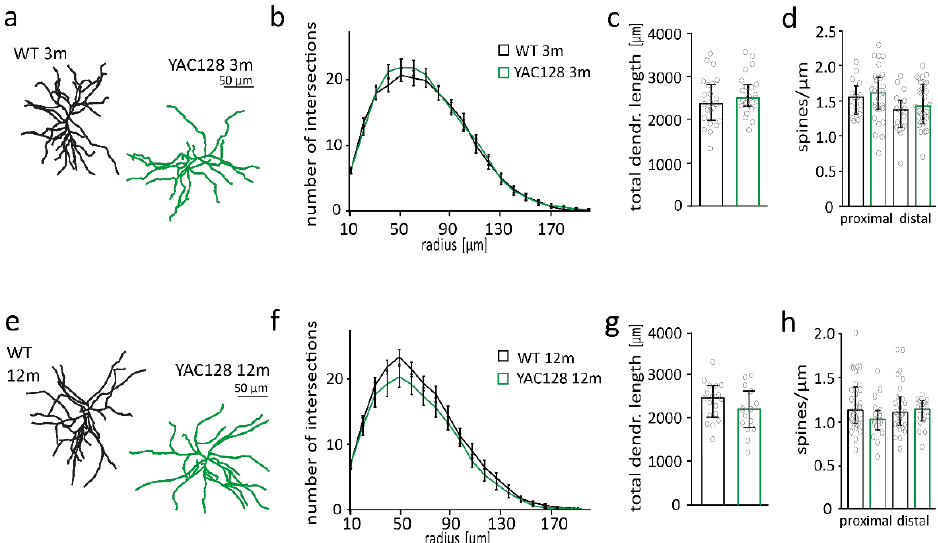
Figure 1. Neuron morphology is unaltered in 3- and 12-month-old YAC128/BL6 mice. ( a ) Examples of reconstructed medium spiny neurons (MSNs) from 3-month-old WT and YAC128/BL6 mice. ( b ) Sholl analysis with number of dendrite intersections and ( c ) bar graph of total dendritic length of MSNs from WT ( n = 23) and YAC128/BL6 ( n = 23) mice. ( d ) Bar graph of spine number per micrometer of proximal and distal dendrites of MSNs from WT (proximal n = 16, distal n = 17)